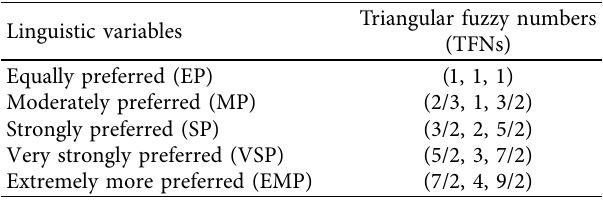
Table 2: For the evaluation of criteria, linguistic variables and TFNs are